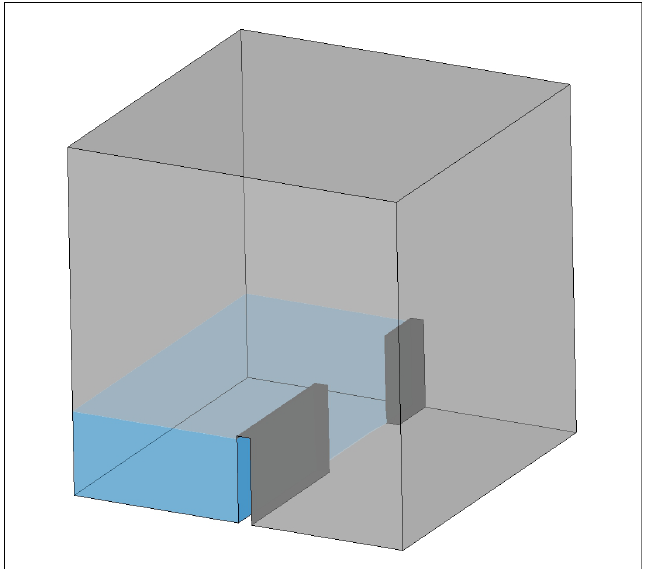
Figure 18. Geometric schematization of 3D Dam